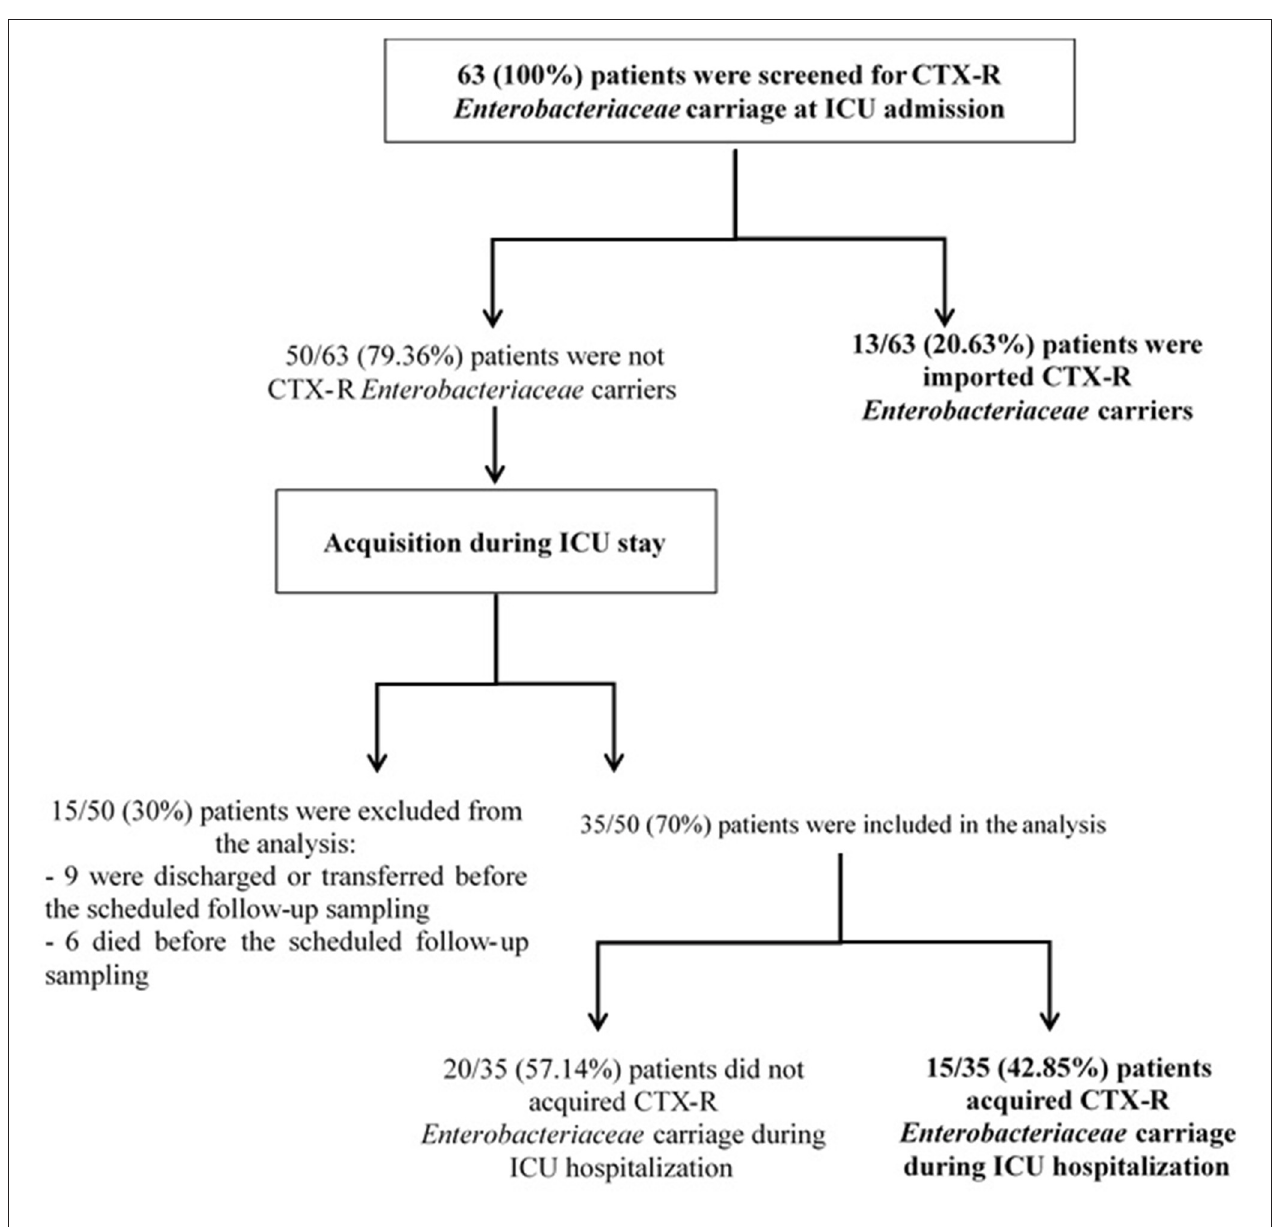
FIGURE 1 | Flow chart of the patients.